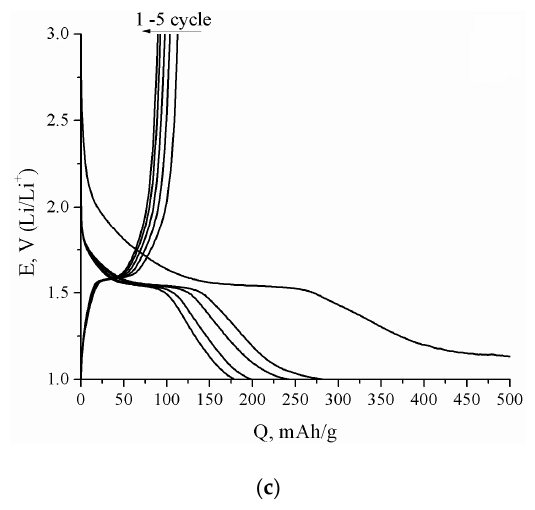
Figure 7. Charge-discharge curves of the LTO/20%G_157M ( a ), LTO/20%CB ( b ), and LTO/20%CR ( c ) composites. Current density 20 mA/g.